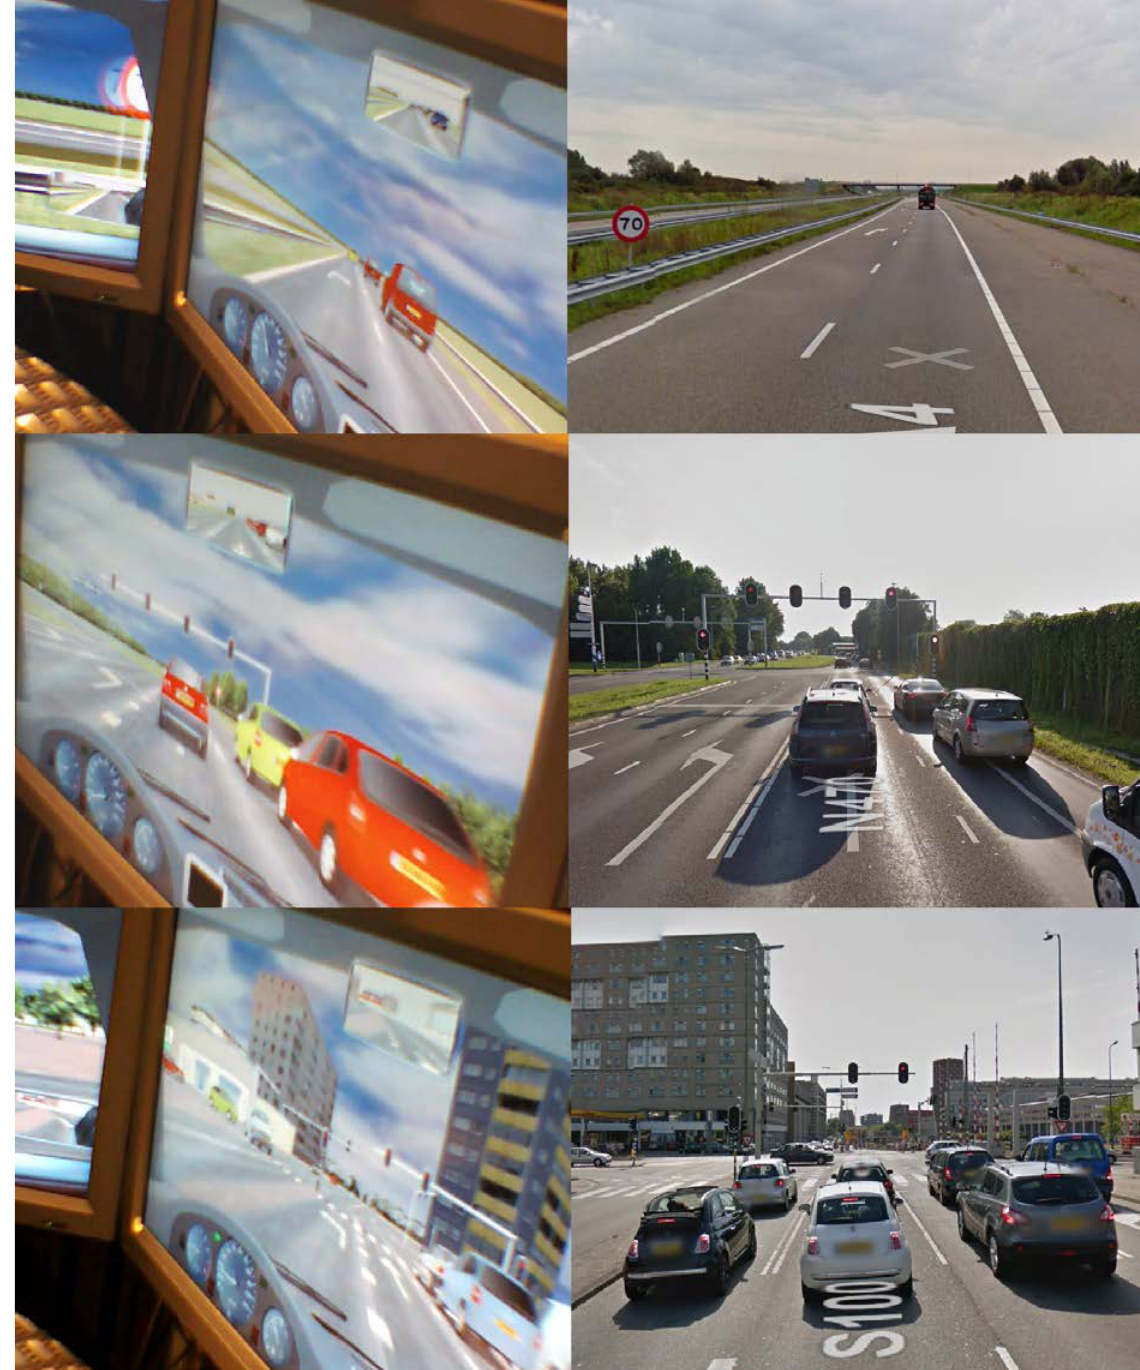
Figure 3. Several simulated environments alongside their approximate real-world counterparts (© Google Maps; Simulator pictures and real life screenshots have different viewing